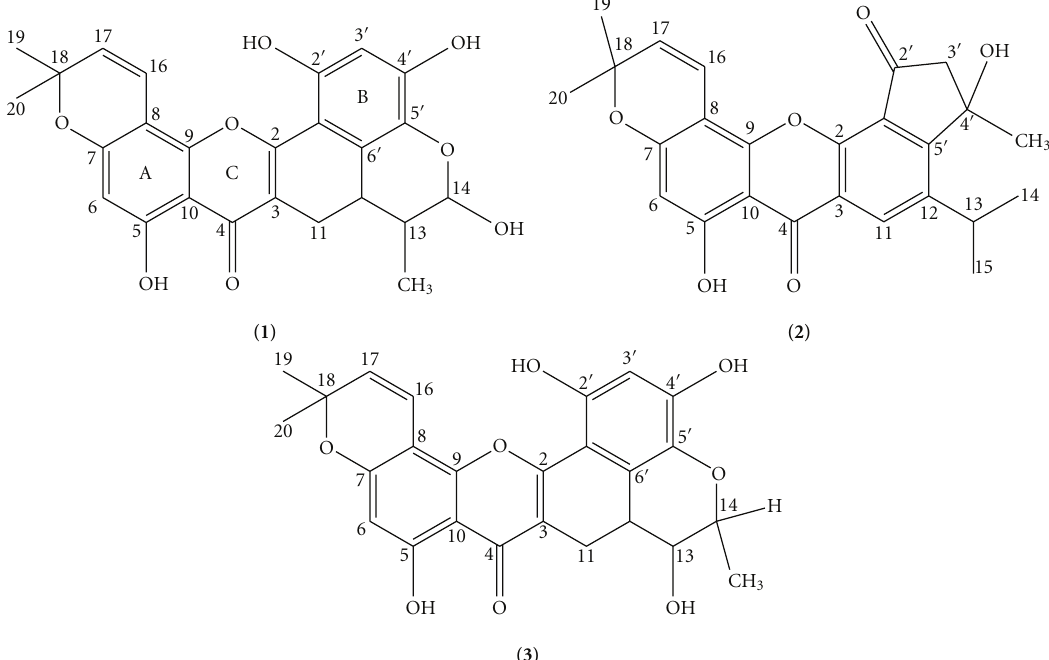
Figure 1: The chemical structure of the three isolated compounds tested for antiproliferative activity, pyranocycloartobiloxanthone A ( 1 ), dihydroartoindonesianin C ( 2 ), and pyranocycloartobiloxanthone B ( 3 ).